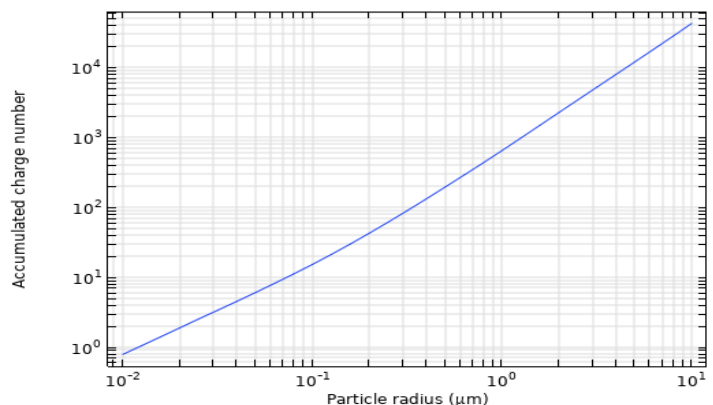
Figure 6: Average charge accumulated per particle at the last time step as function of particle